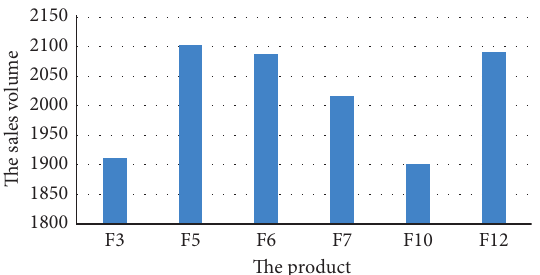
Figure 7: Sales volume under different recommendation decisions.